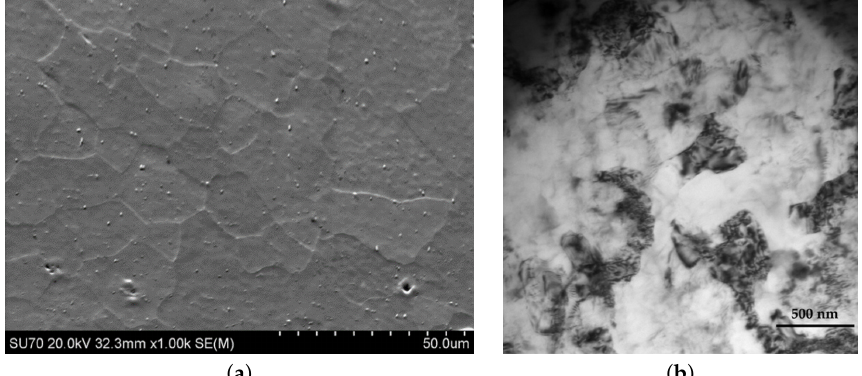
Figure 6. Grain size evolution through Asymmetric rolling (ASR): ( a ) initial grains of AA5182 before rolling observed by SEM (Scanning Electron Microscopy) and ( b ) new fine grains after ASR (85% thickness reduction) observed by TEM (Transmission Electron